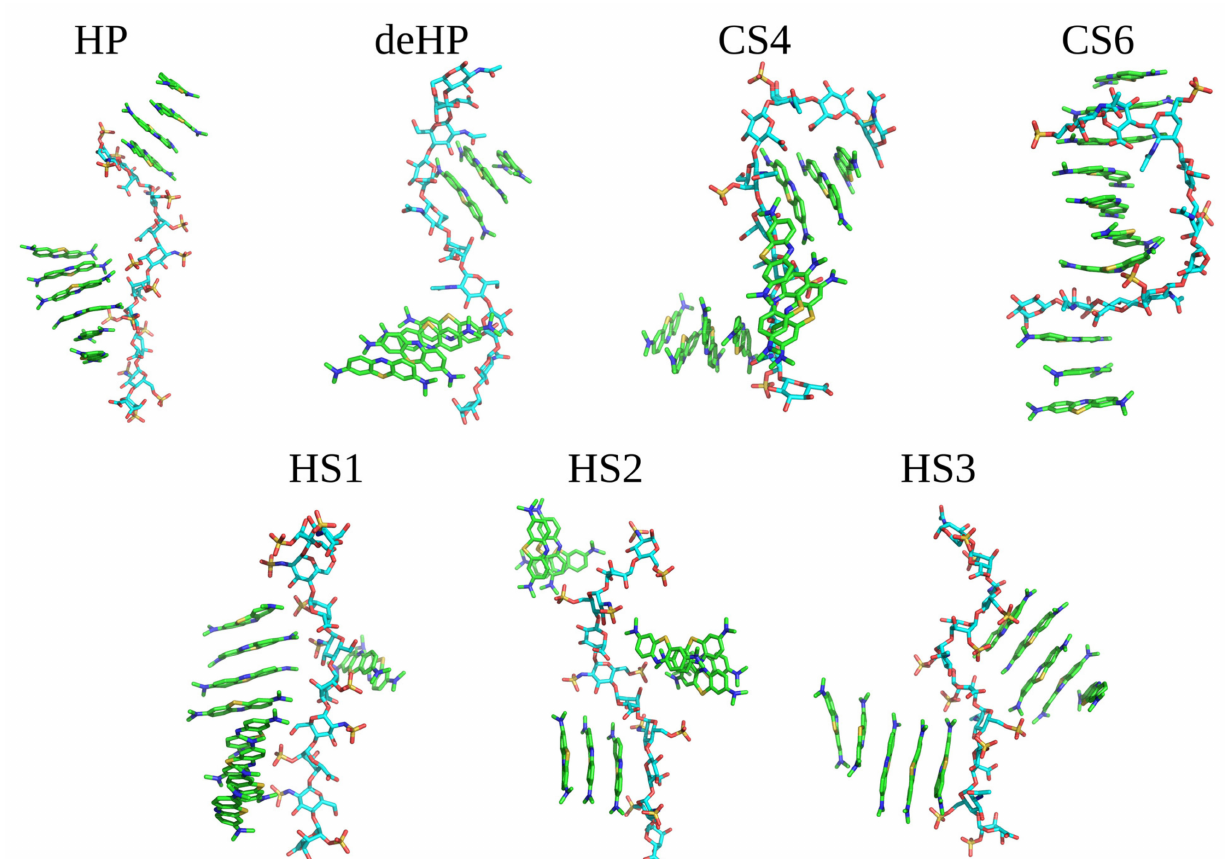
Figure 4. Examples of MB–GAG dp10 complex structures obtained in MD simulations (MB molecules are shown as in Figure 3; GAGs dp10: light blue—carbon atoms, red—oxygen atoms, blue—nitrogen atoms and yellow—sulfur